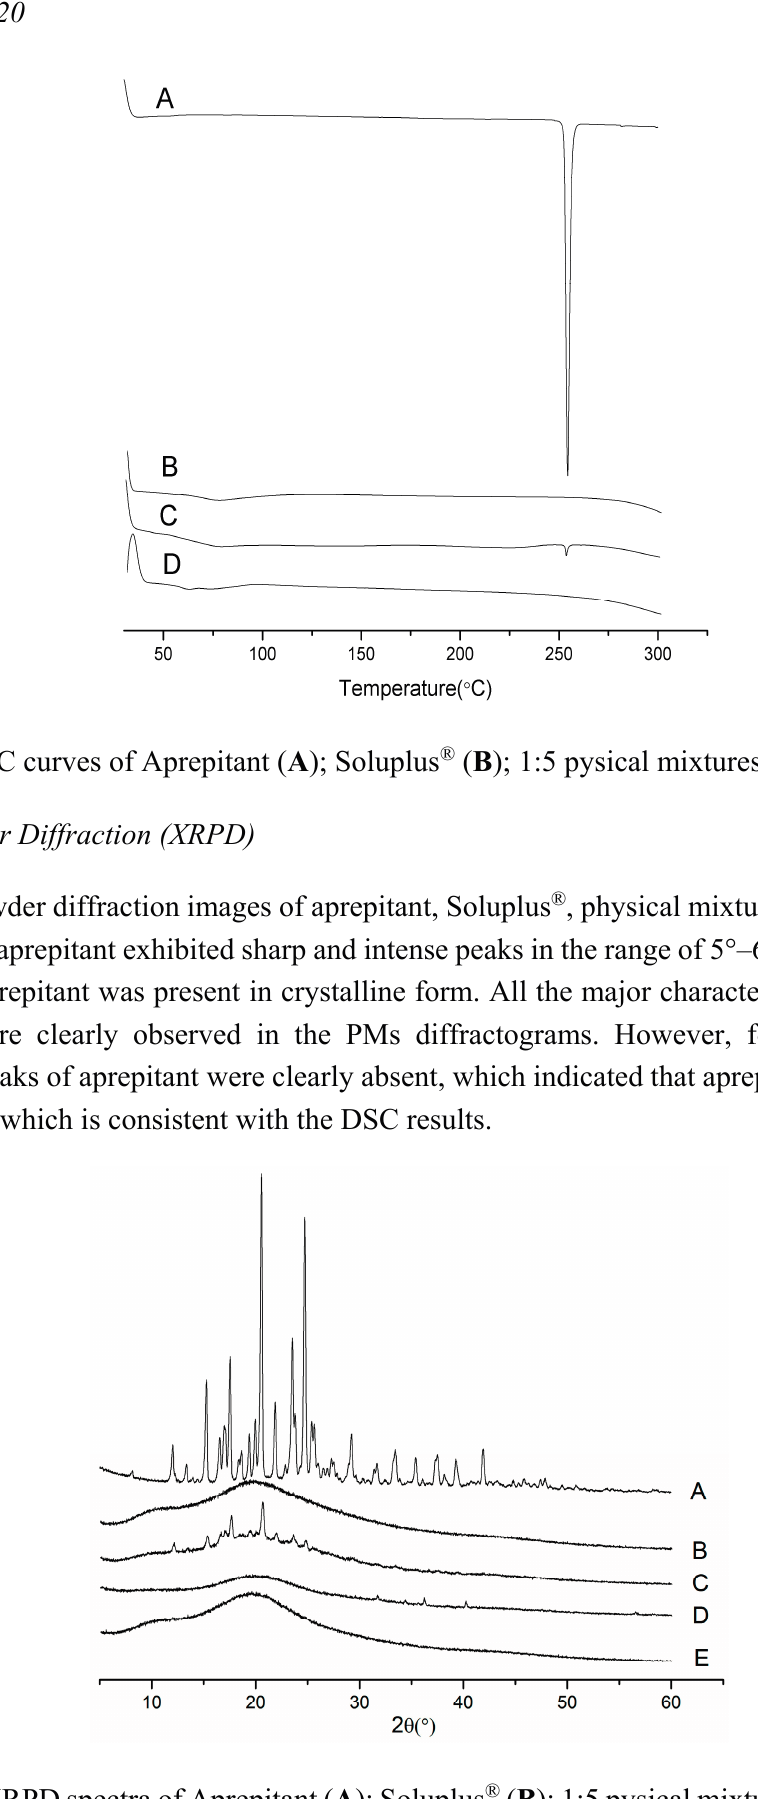
Figure 3. XRPD spectra of Aprepitant ( A ); Soluplus ® ( B ); 1:5 pysical mixtures ( C ); 1:1 SDs ( D ); 1:5 SDs ( E